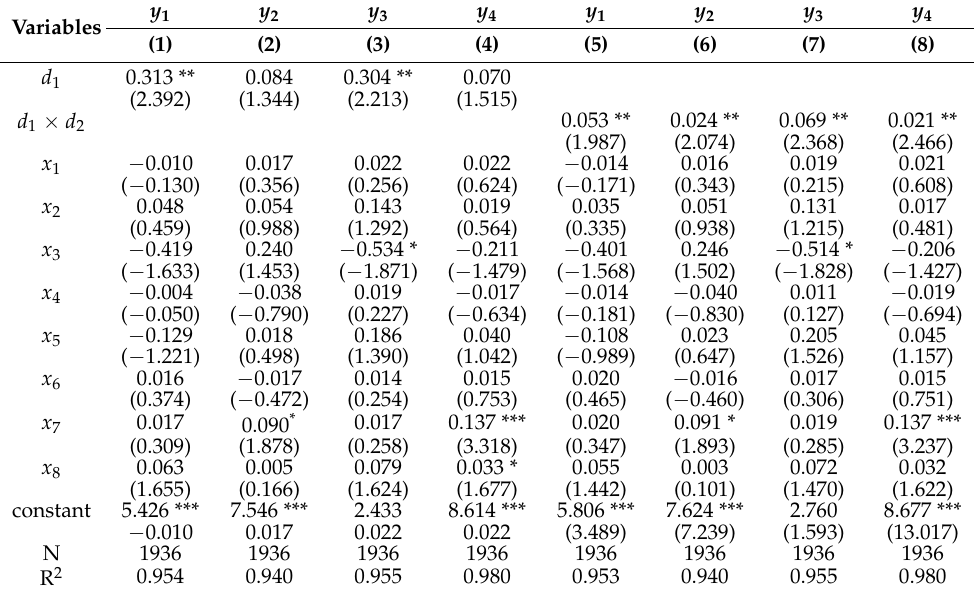
Table 2. Results of the nonspatial econometric estimation.